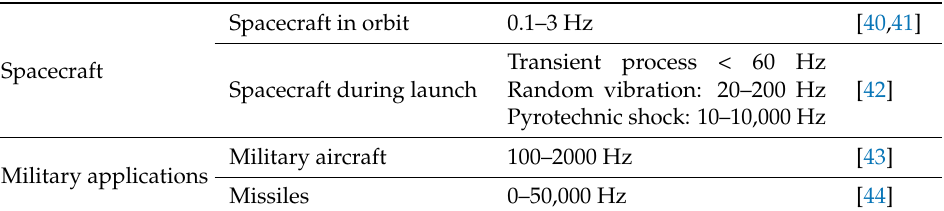
Table 3. Vibration frequency band for heavy duty